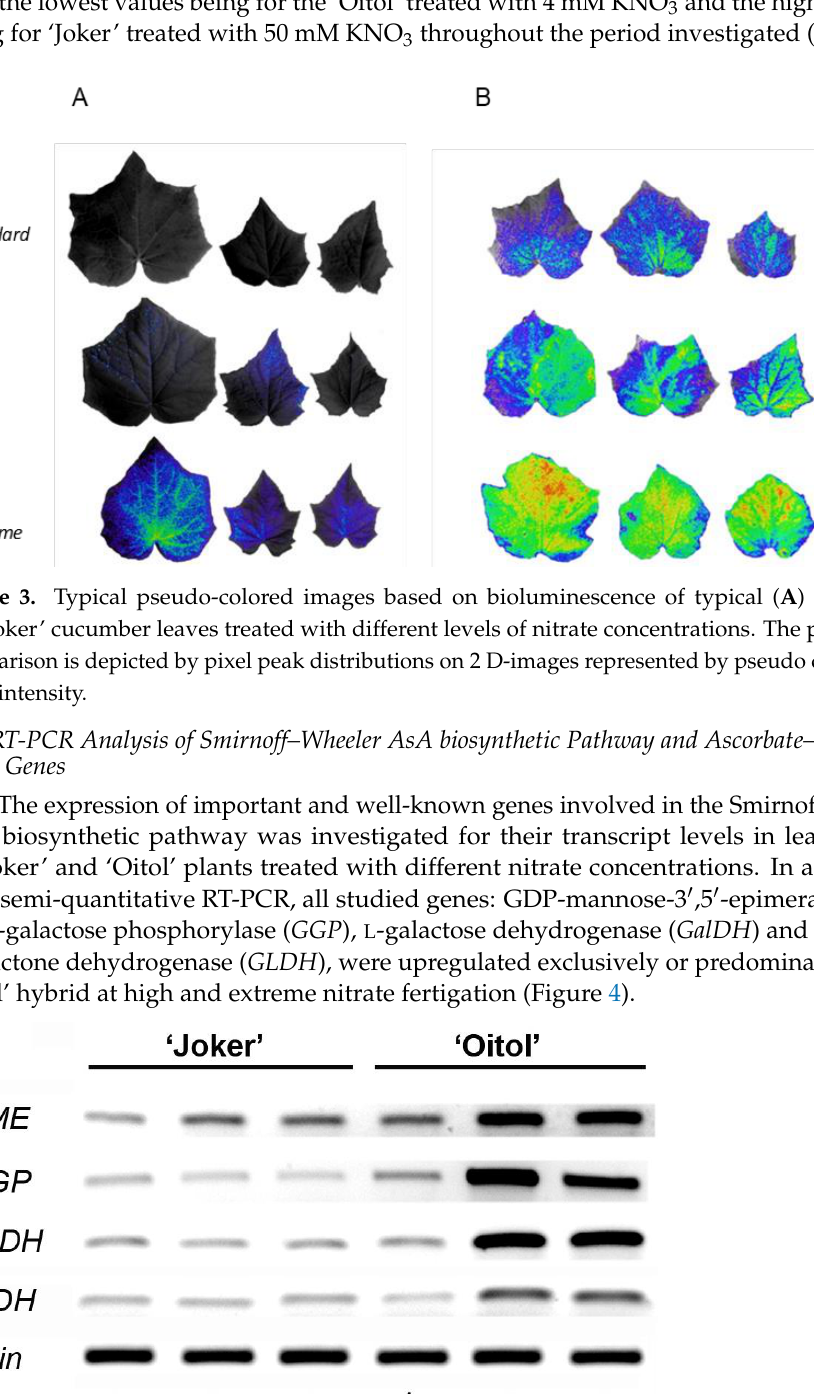
Figure 4. Semiquantitative RT-PCR expression analysis of Smirnoff–Wheeler AsA biosynthetic path- way genes in the leaves of two F1 cucumber hybrid lines treated with different nitrate concentra- tions. GME : GDP-mannose-3′,5′-epimerase; GGP : GDP-galactose phosphorylase; GalDH : L -galactose